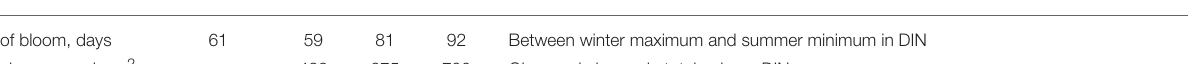
TABLE 6 | Primary production at AFBI’s mooring station (38/38A) during the Spring Bloom based on Gowen et al. (1998a) for 1992–1996 and unpublished AFBI data.